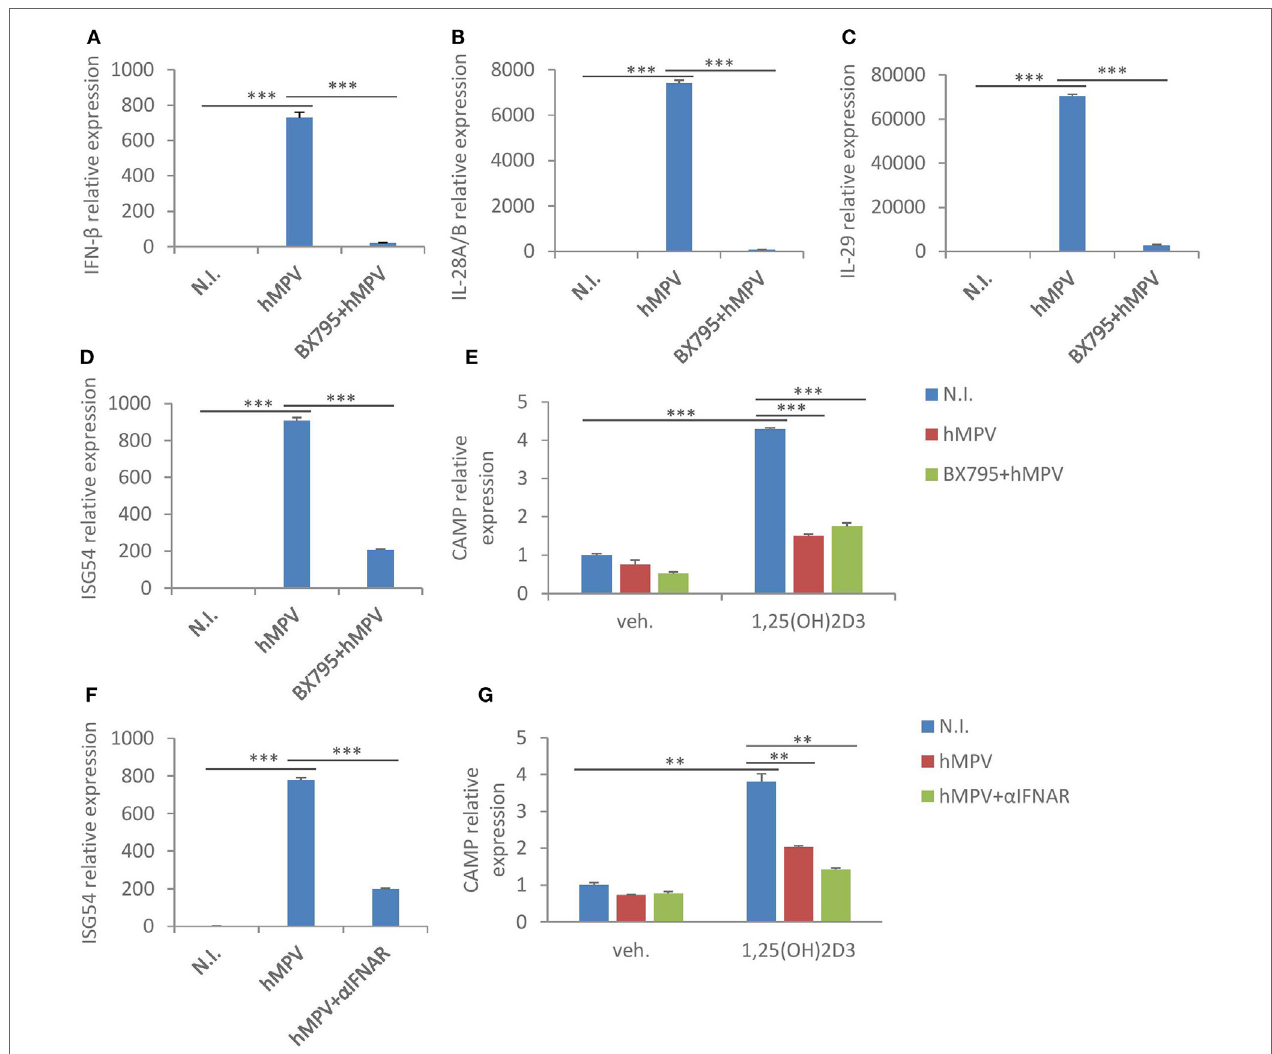
FigUre 4 | Human metapneumovirus (hMPV)­mediated suppression of cathelicidin antimicriobial peptide (CAMP) is largely interferon­independent. (a–D) Monocyte­derived macrophages (MDMs) were mock­infected (N.I.), infected with hMPV (hMPV) or pretreated with BX795 before hMPV infection (BX795 + hMPV) for 24 h. mRNA expression of IFN­ β (a) , IL­28A/B (B) , IL­29 (c) , and ISG54 (D) was assessed by quantitative real­time PCR (qRT­PCR). ( e) Same set­up for hMPV infection and BX795 pretreatment as (a–D) , concomitant with or without 1,25(OH) 2 D 3 treatment. CAMP mRNA expression was assessed by qRT­PCR. (F) MDMs were mock­infected (N.I.), infected with hMPV (hMPV) or pretreated with IFNAR2 neutralizing antibody ( α IFNAR) before hMPV infection (hMPV + α IFNAR) for 24 h. mRNA expression of ISG54 was assessed by qRT­PCR. (g) Same set­up for hMPV infection and α IFNAR pretreatment as (F) , concomitant with or without 1,25(OH) 2 D 3 treatment. CAMP mRNA expression was assessed by qRT­PCR. Error bars represent SD for triplicates. ** p < 0.01, *** p < 0.001. Data are representative of at least three independent experiments from different